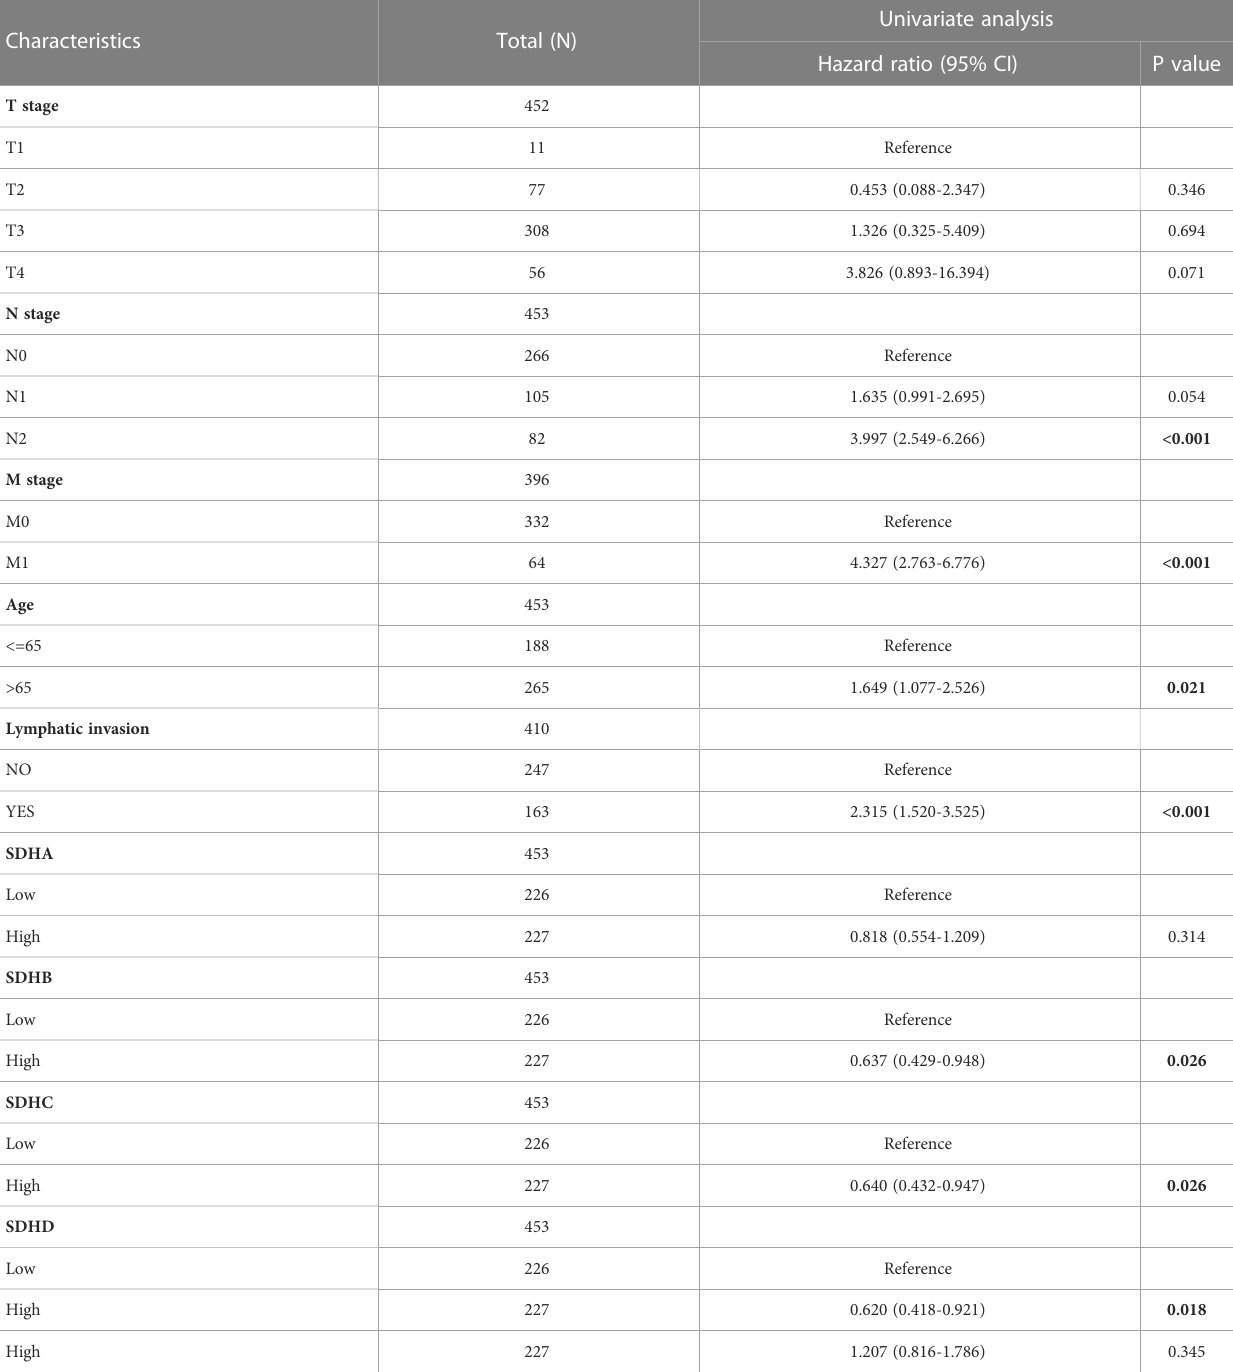
The bold letters in the fi rst column represent different clinical characteristics. And the bold letters in the fourth column represent the clinical characteristics is signi fi cant (P <